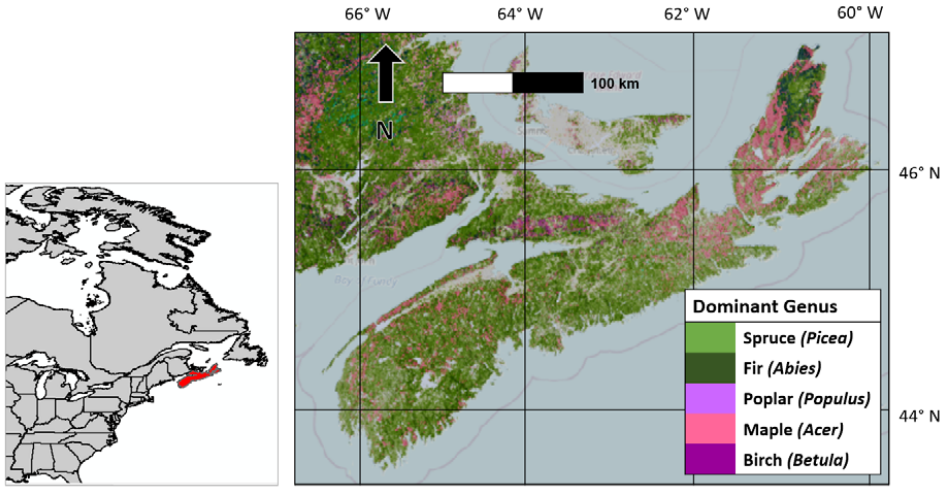
Figure 2. Location of Nova Scotia in Northeastern North America, and dominant tree genus